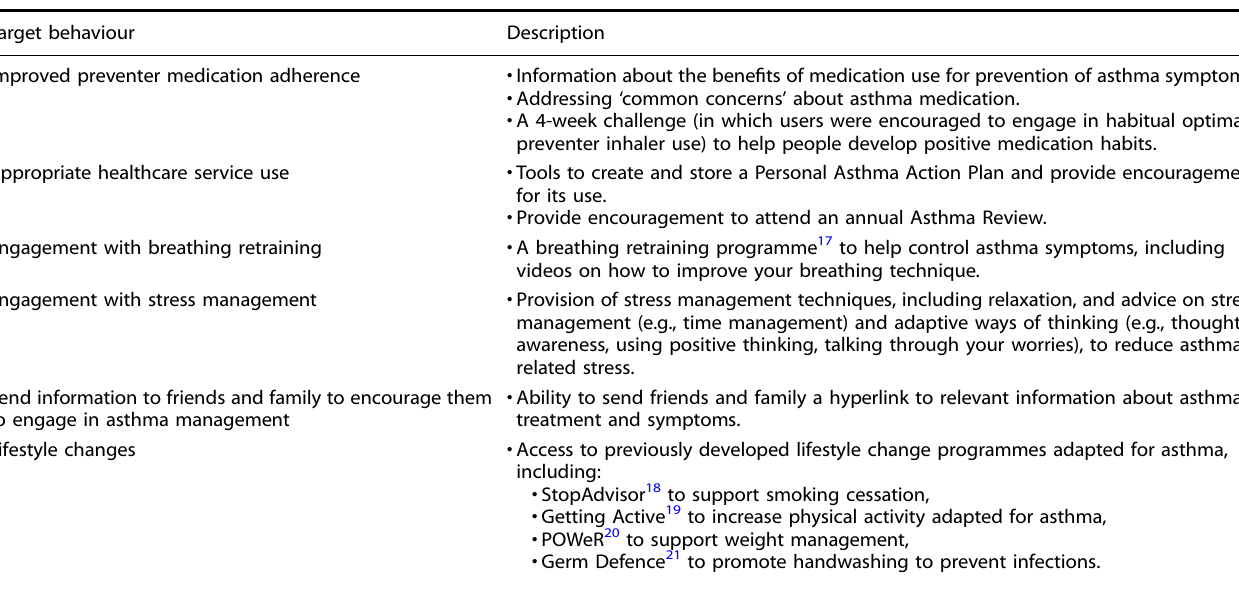
Table 5. Description of My Breathing Matters intervention components. Target